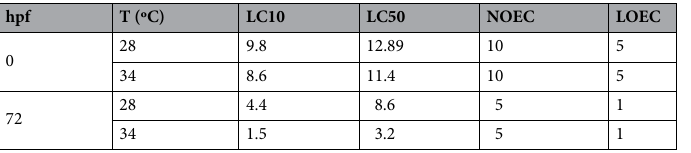
Table 3. Toxicity of 0 and 72 hpf embryos exposed to ET-NEs for 96 h. hpf: hour post- fertilization; LC10, LC50, NOEC and LOEC are represented in